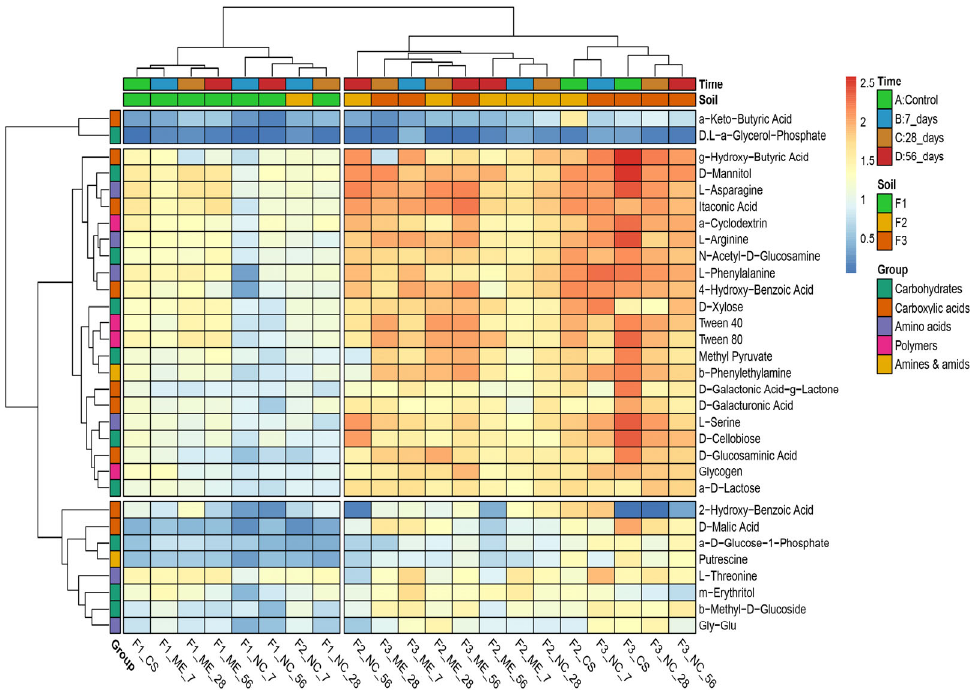
Figure 10. Heatmap and clustering tree for utilization of individual carbon sources (EcoPlate™ Biolog ® ) by the soil microorganism community from three fluvisol during the model experiment and natural condition. Lack of or low utilisation is represented by a dark blue colour; the gradient from light blue to red represents positive utilisation; the colour key scale (0.5–2.5) for each substrate is based on dye reduction, quantified by Omnilog units (EcoPlate™ Biolog ® ). Explanation of the samples in Table 1.